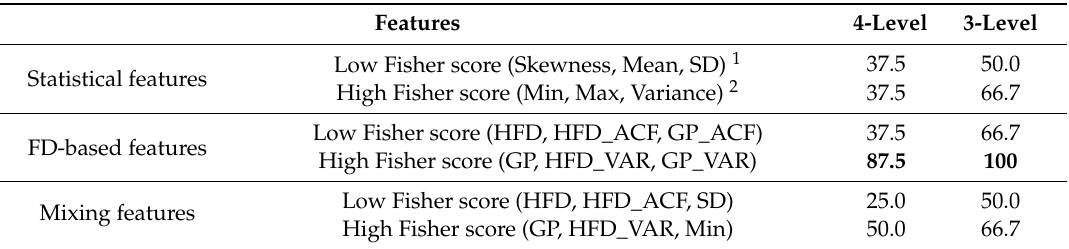
Table 5. Comparison of classification accuracy (%) between combined statistical features and FD-based combined features selected by Fisher score. The highest accuracy is shown in bold.